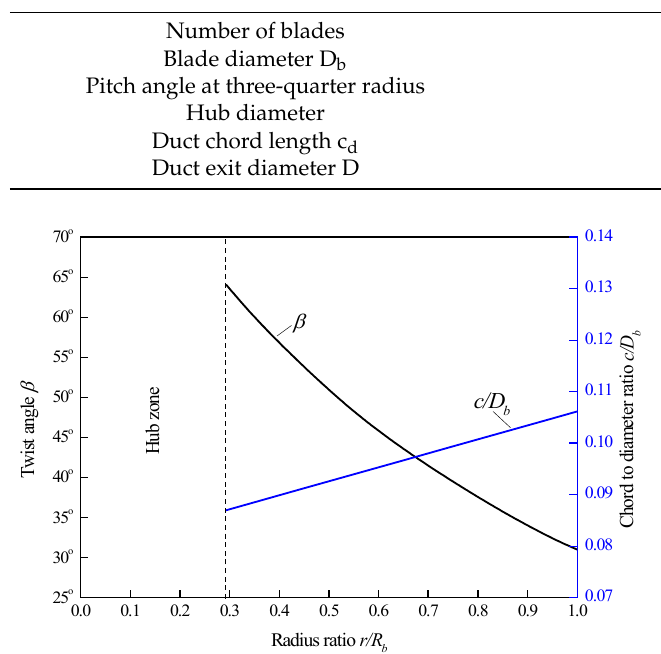
Figure 2. Blade chord and twist distributions. Table 1. Main parameters of the ducted fan.